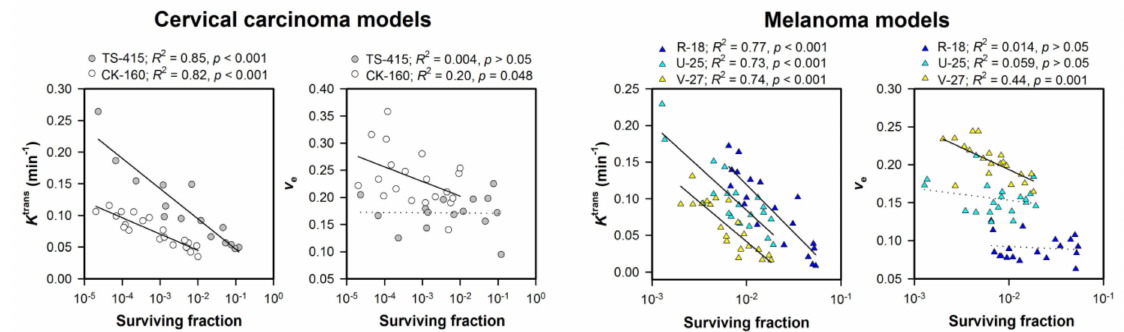
Figure 4. Xenografted tumors were subjected to DCE-MRI prior to fractionated or single-dose irradiation. The figure shows median K trans versus cell surviving fraction and median v e versus cell surviving fraction in TS-415 and CK-160 cervical carcinoma xenografts, and R-18, U-25, and V-27 melanoma xenografts. The cervical carcinoma xenografts were irradiated with 5 fractions of 4 gray (Gy) in 48 h, and the melanoma xenografts were irradiated with a single dose of 10 Gy. The cell survival of irradiated tumors was measured in vitro as detailed previously [39]. Briefly, the tumors were resected immediately after the last radiation fraction, minced in saline and treated with an enzyme solution. Trypan blue negative cells were plated in tissue culture flasks and incubated for 14 days for colony formation. The cell surviving fraction of an irradiated tumor was calculated from the number of cells plated, the number of colonies counted, and the mean plating e ffi ciency of the cells. Points represent individual tumors, and curves were fitted to the data by linear regression analysis. p -values were obtained by Pearson product moment correlation test. Modified from Ellingsen et al. [26] and Øvrebø et al.